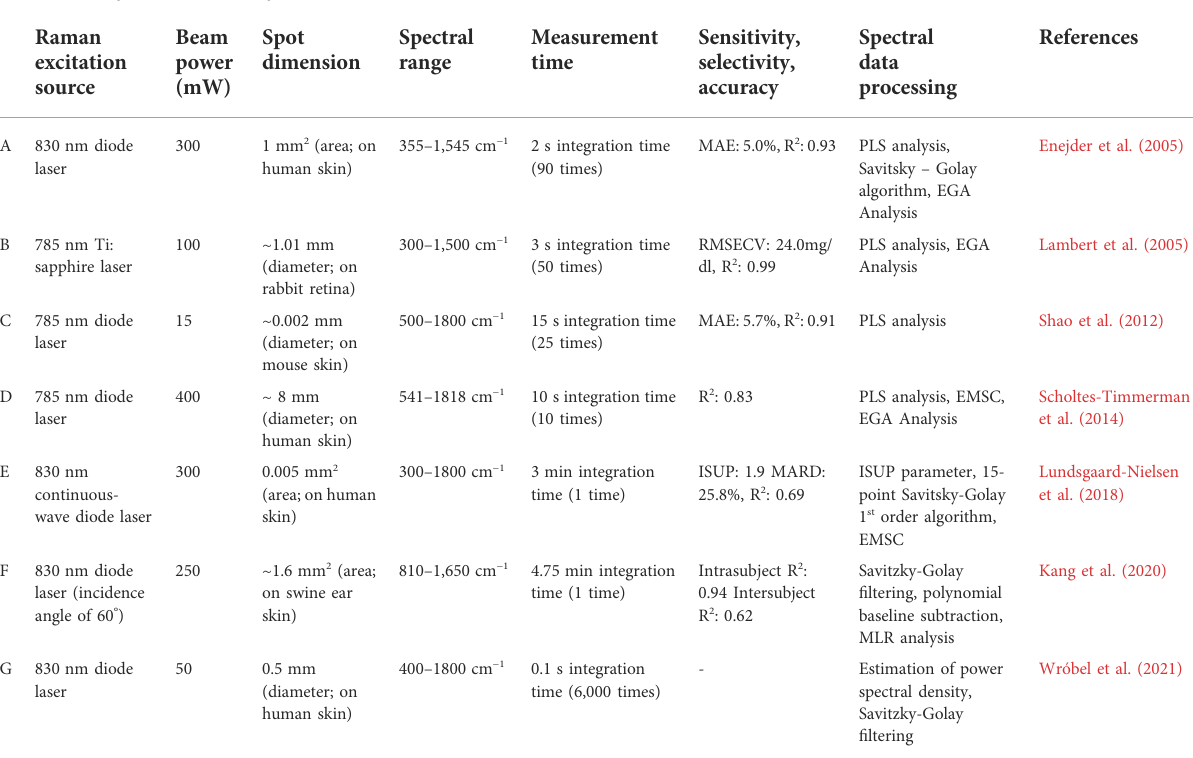
TABLE 1 Example of Raman